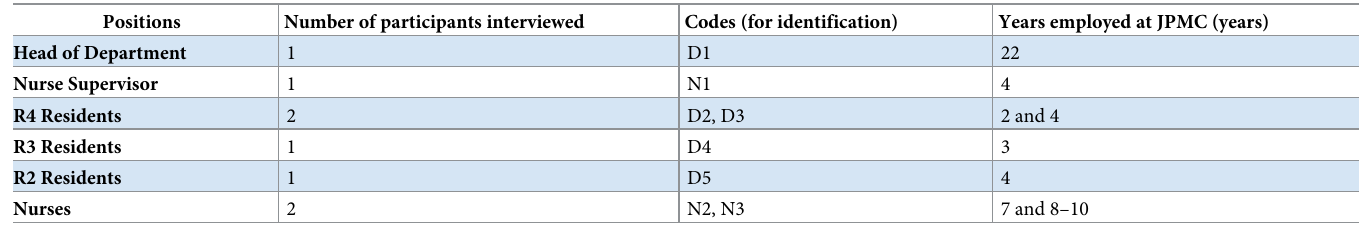
Table 1. Grid for key informant interviews � .